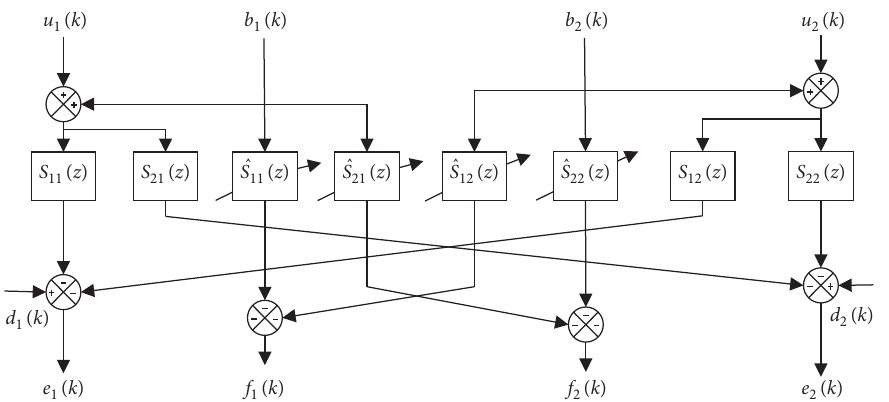
Figure 11: MIMO online system identification [127].